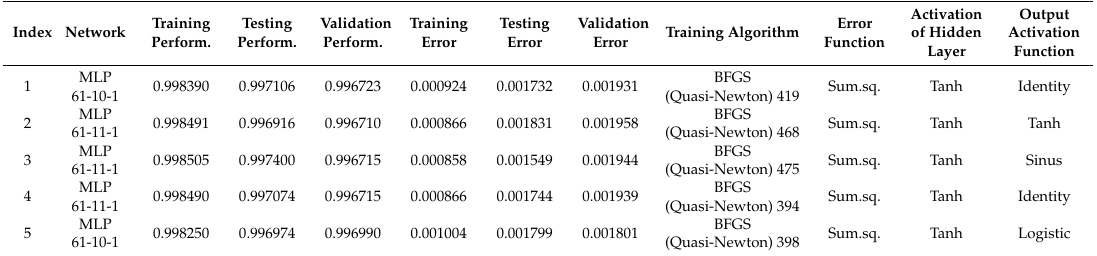
Table 6. Retained neural networks.